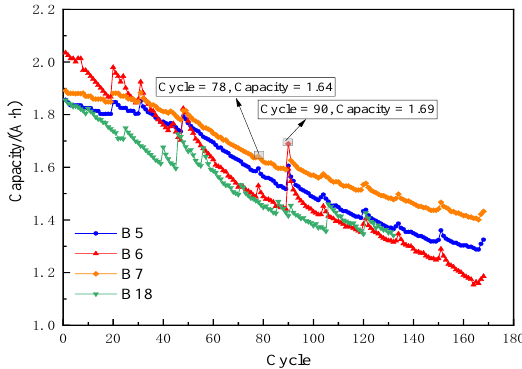
Figure 5. NASA battery capacity degradation curve.